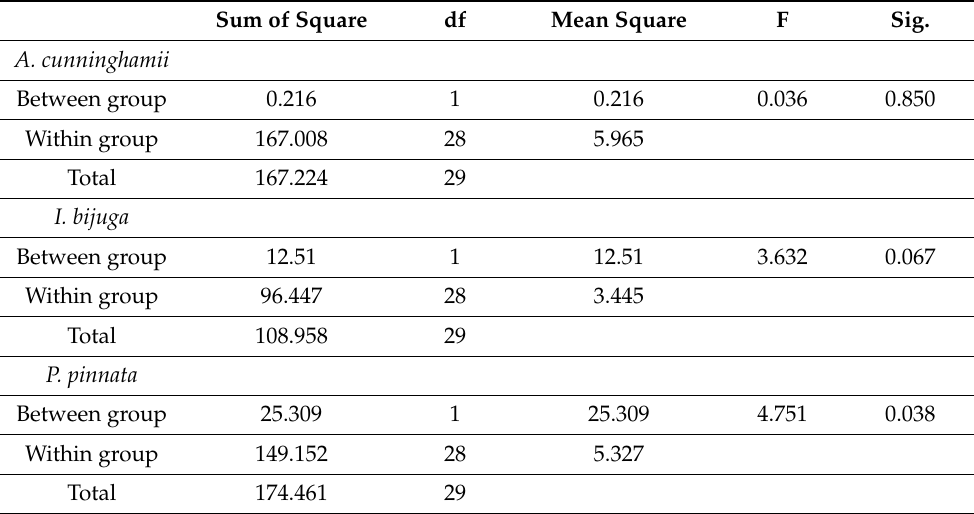
Figure 2. Boxplot analysis of heat energy output of treatment and control specimens of test species. Table 5. ANOVA of heat calorific value of wood pellets and solid wood of test